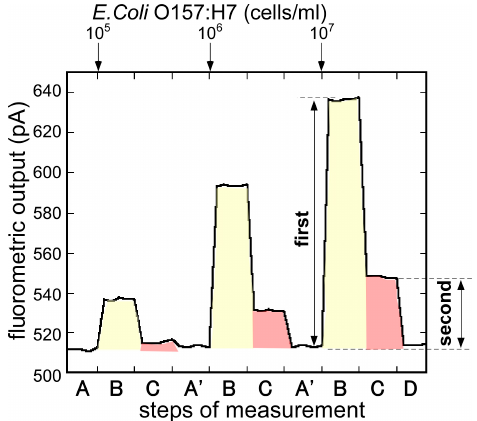
Figure 7. Typical response of magnetic bead attach/release measurement to the different concentrations of E. coli O157:H7 (1.0 × 10 5 , 1.0 × 10 6 , 1 × 10 7 cells/mL). First output: signal differences between step A and step B (magnetic bead attach); Second output: signal differences between step B and step C (magnetic bead release).